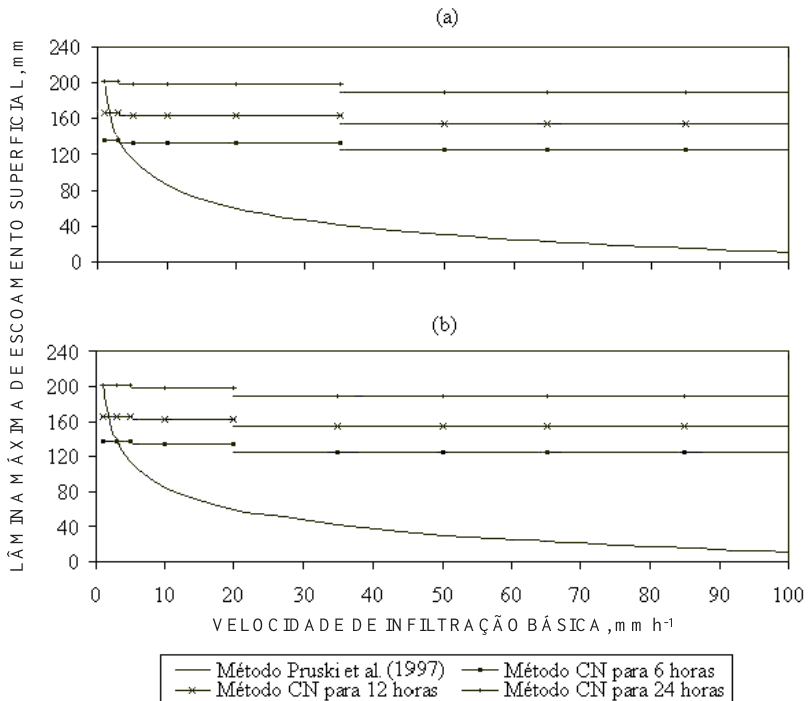
Figura 4. Representação, para Uberlândia, da variação da lâmina máxima de escoamento superficial com a VIB por meio dos métodos propostos por Pruski et al. (1997) e número da curva, utilizando os critérios apresentados por Pruski et al. (1997) (a) e SCS (b) para a classificação do solo nos grupos propostos pelo SCS para o método do número da